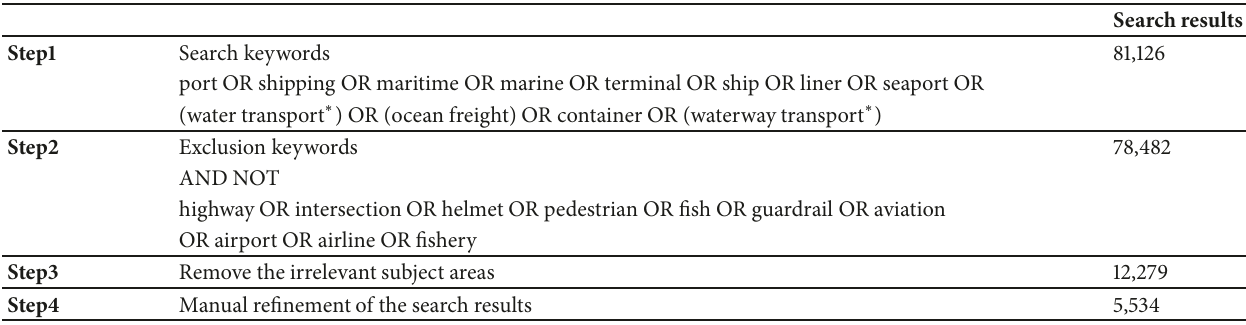
Table 1: Process of the material collection.